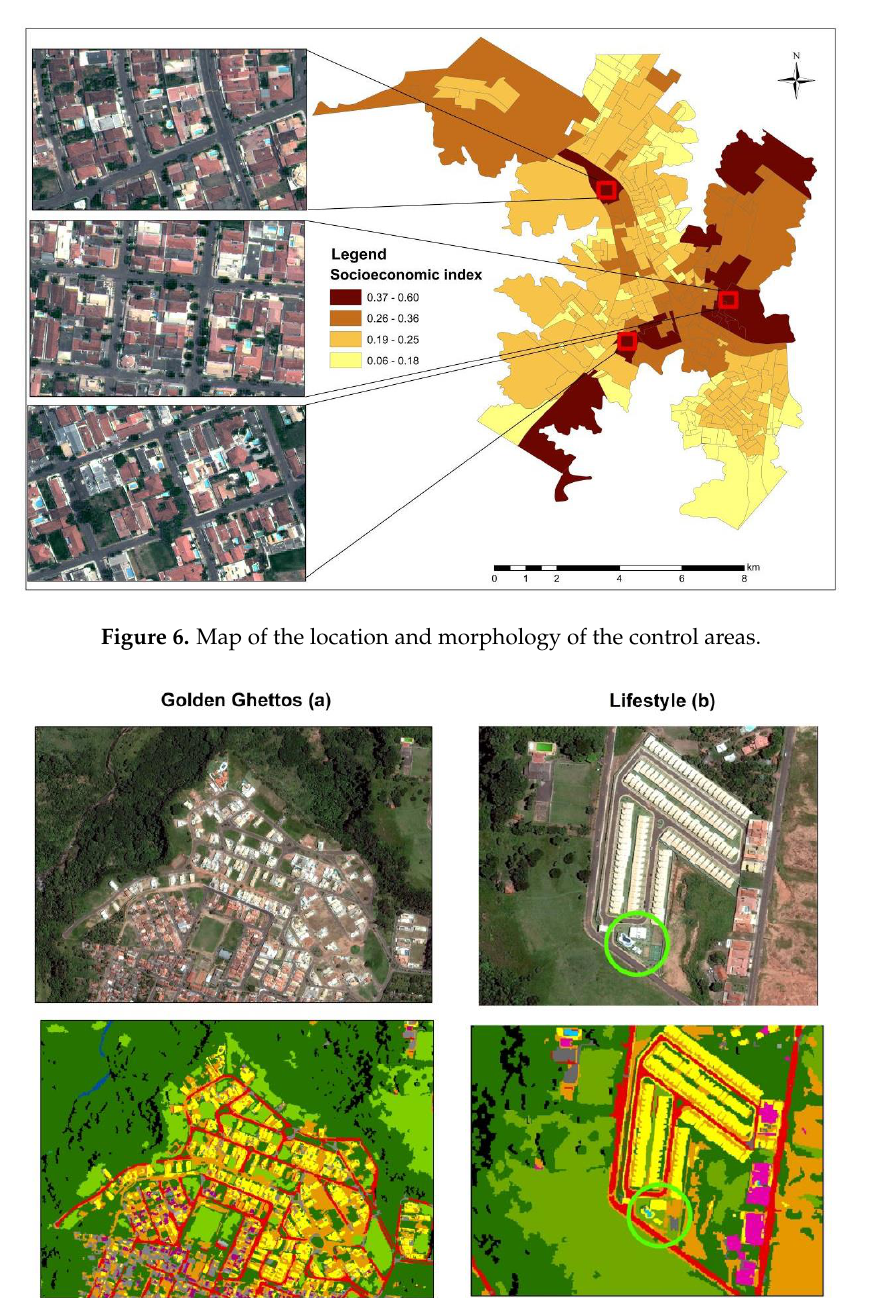
Figure 7. Garden Park (golden ghetto ( a )) and Collibri gated communities (GC) (lifestyle ( b )).